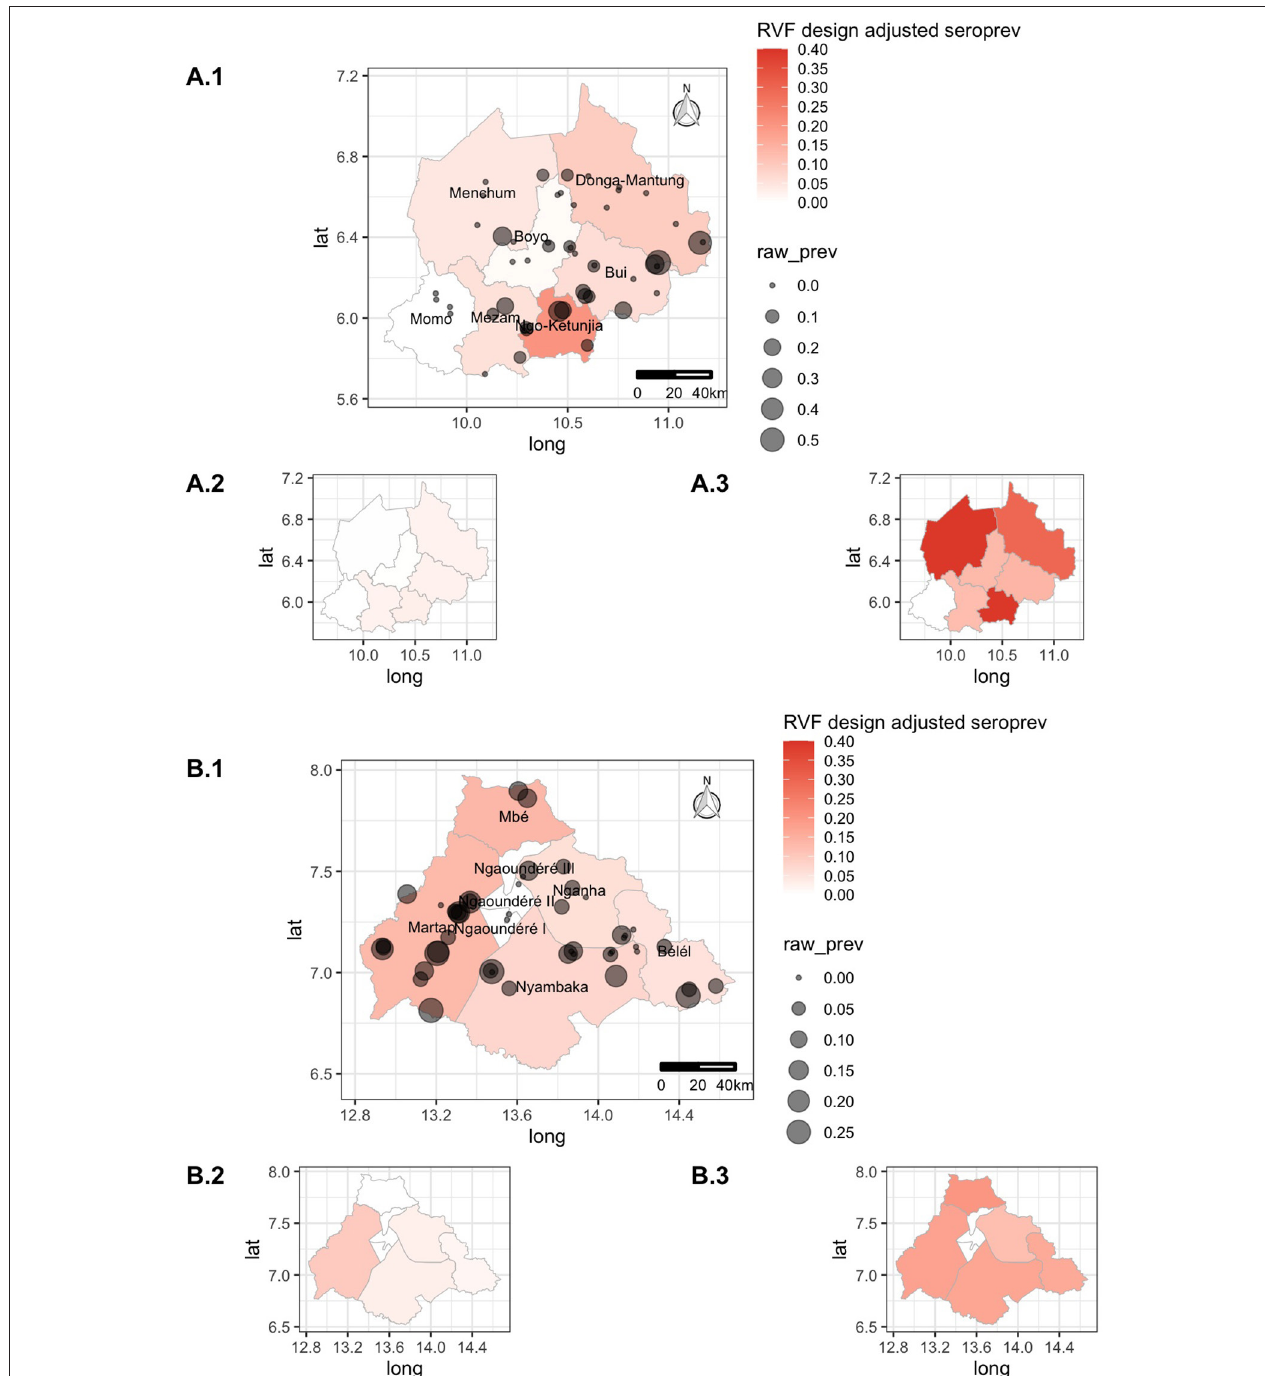
FIGURE 3 | Choropleth maps of the Northwest Region (NWR) (A) and Vina Division (VIN) (B) in Cameroon colored by design-adjusted apparent seroprevalence for the administrative strata, overlaid with the approximate location of individual herds sized by the raw proportion of animals positive within each herd. The smaller inset choropleth maps are for the lower (X.2) and upper (X.3) 95% confidence intervals, respectively, for each